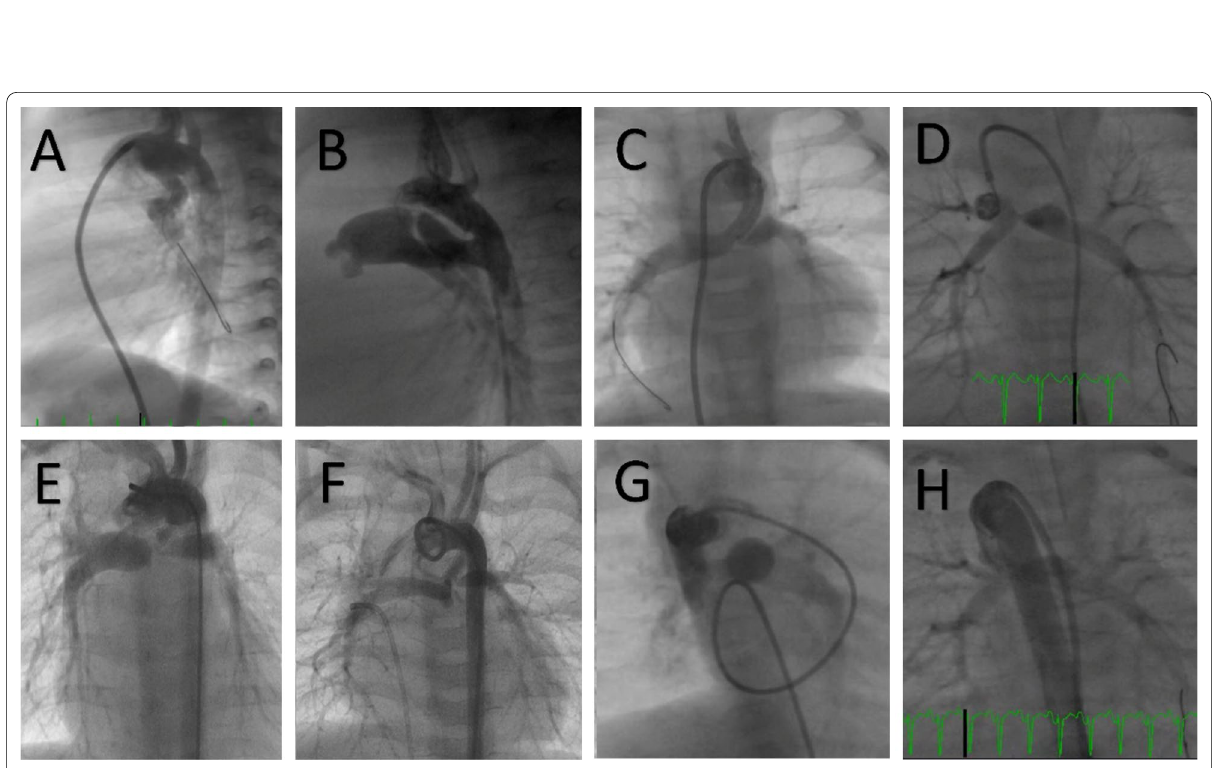
Fig. 4 Left pulmonary artery (LPA) stenosis and growth of pulmonary arteries associated with ductal stenting. A The vertical duct from the undersurface of the aortic arch, B The regular conical duct from the proximal descending aorta. C , D Pre‑existing LPA stenosis. On routine follow‑up angiography, there was a development of stent stenosis and LPA stenosis ( E , F ). Follow‑up angiography images show adequate growth of pulmonary arteries despite right pulmonary artery jailing ( G , H